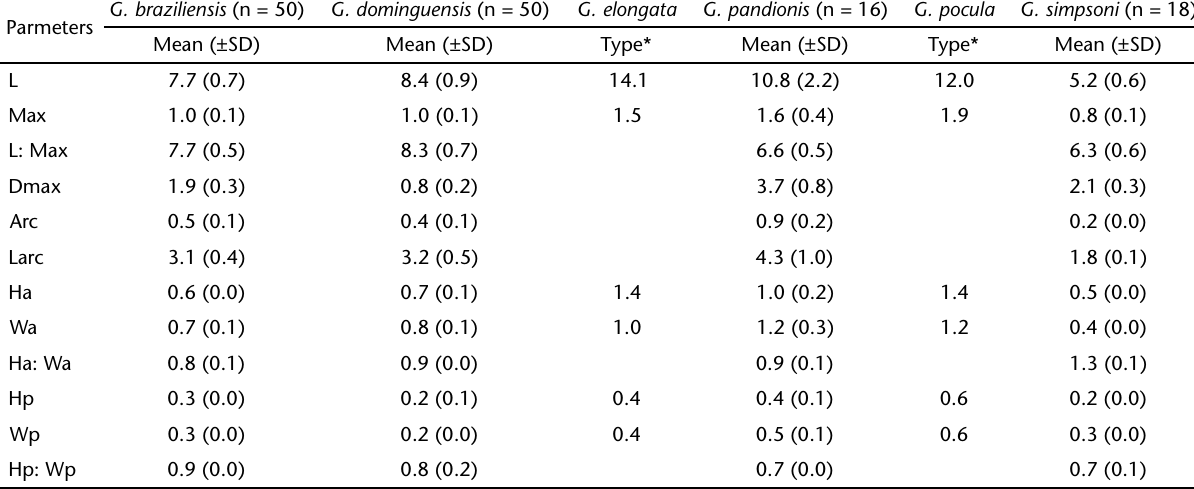
Table I. Values of shell morphometric parameters for species of Gadila from Brasil. (L) Length, (Max) maximum diameter, (Dmax) distance of point of maximum diameter from anterior aperture, (Arc) maximum curvature, (Larc) distance of point of maximum curvature from the apex, (Ha) anterior aperture height, (Wa) anterior aperture width, (Hp) apical aperture height, (Wp) apical aperture width. All measurements are in millimeters. * Type dimensions obtained from H ENDERSON (1920). G. braziliensis (n = Parmeters